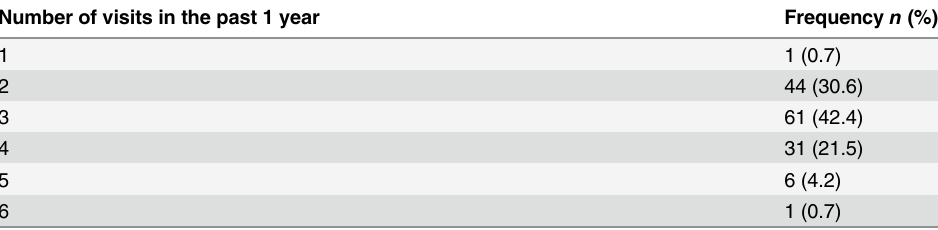
Table 2. Frequency of visits among patients with provider continuity of 1.00 over 1